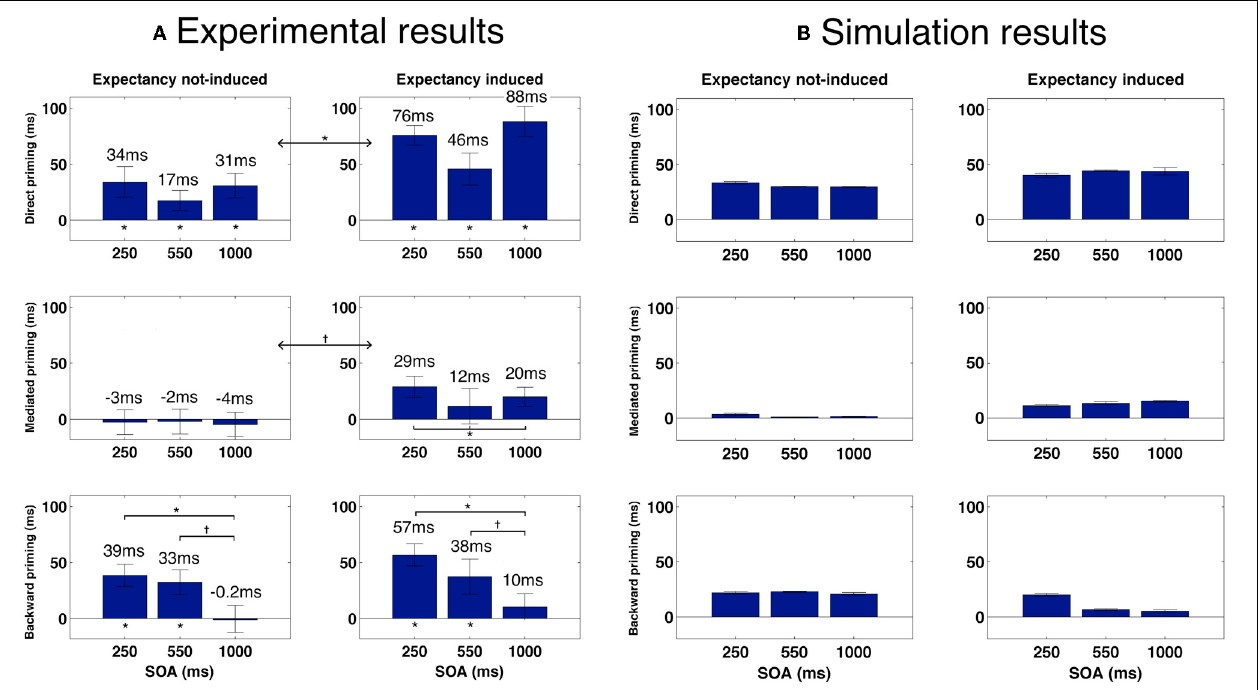
FIGURE 8 | (A) Priming results in Experiment 1. Error bars represent ± 1 standard error of the mean. † indicates significance level of 0.05 or better; ∗ indicates significance level of 0.01 or better. (B) Simulated priming results corresponding to Experiment 1 under equivalent conditions.